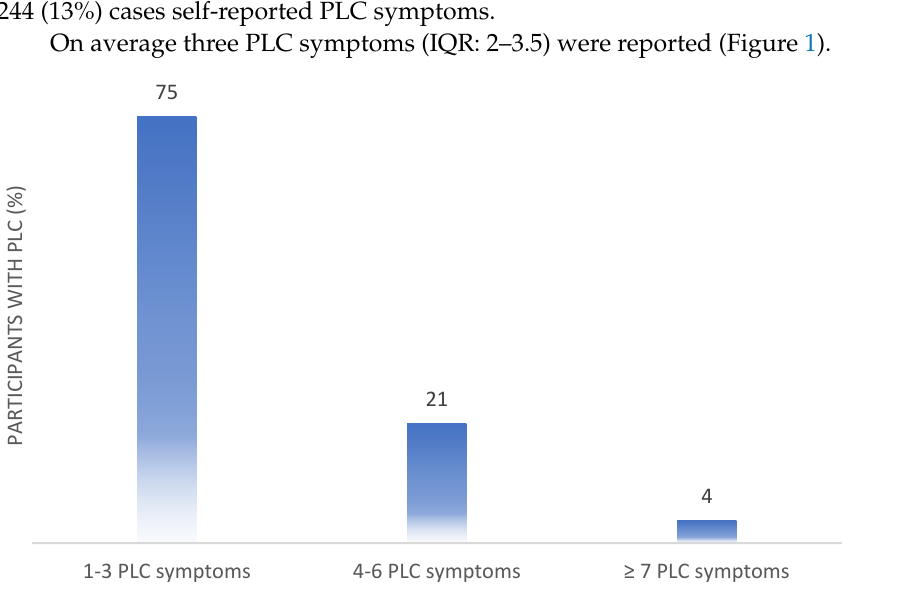
Figure 1. Proportion of participants with 1–3, 4–6 or ≥ 7 PLC symptoms; PLC, post-acute COVID-19